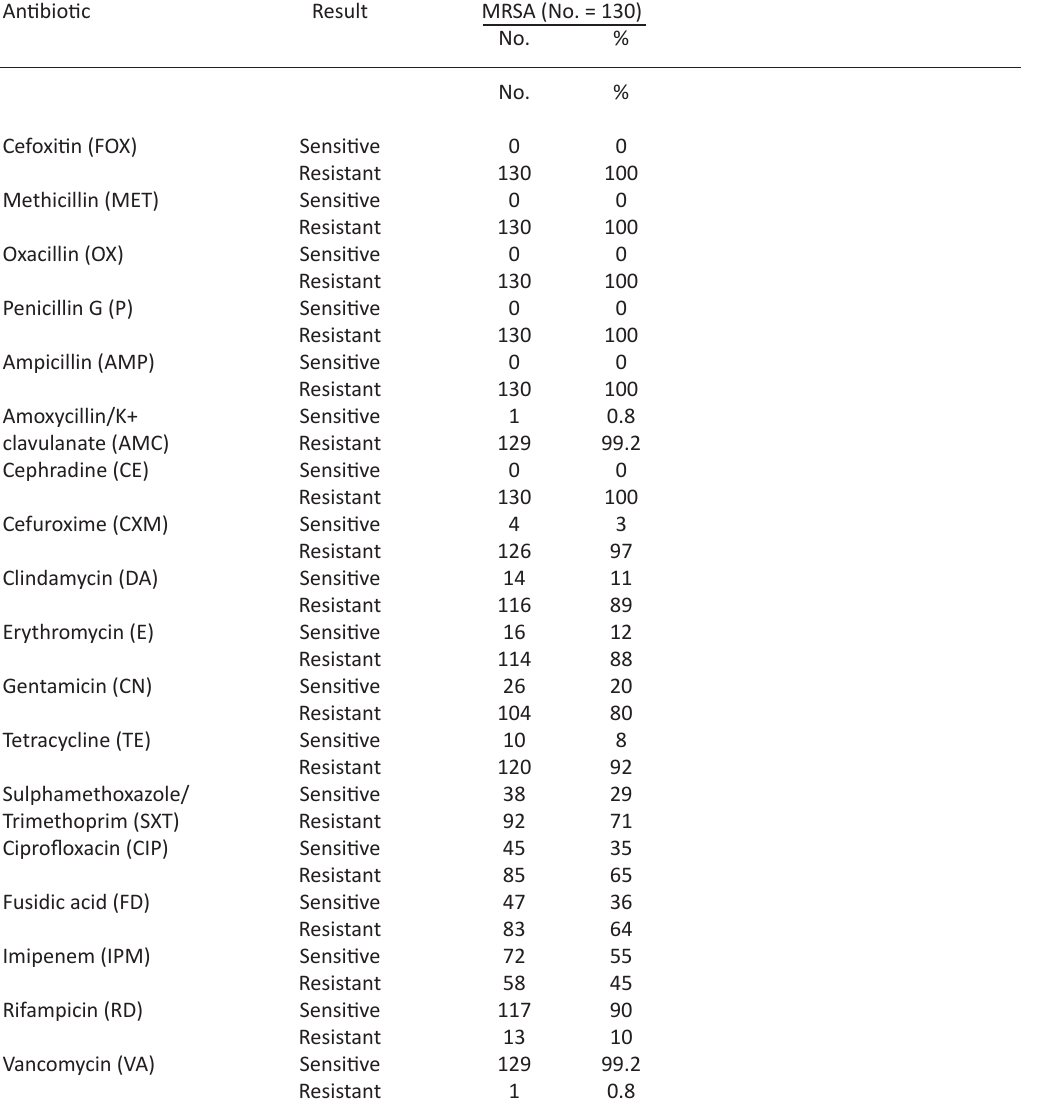
Table 4. Antibiotic sensitivity of the MRSA isolates by the disc diffusion method Antibiotic